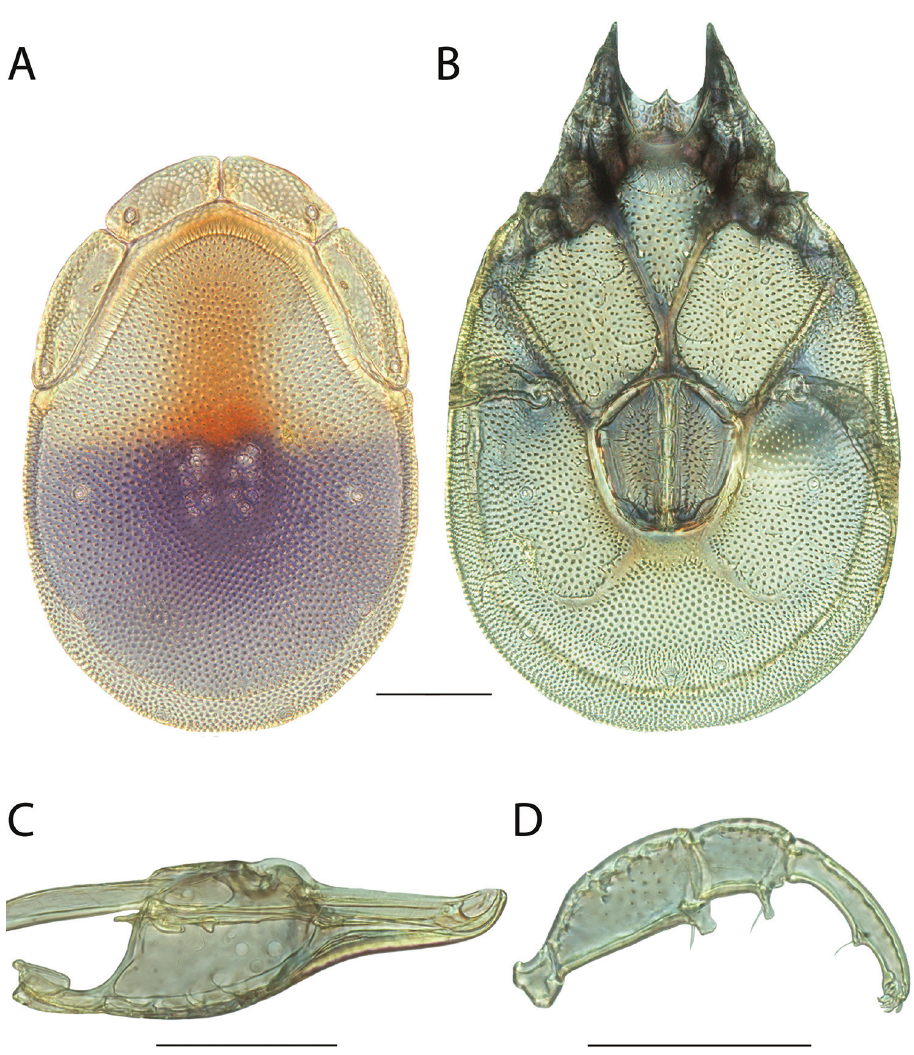
Figure 247. Torrenticola solisorta sp. n. female: A dorsal plates B venter (legs removed) C subcapitulum D pedipalp (setae not accurately depicted). Scale = 100